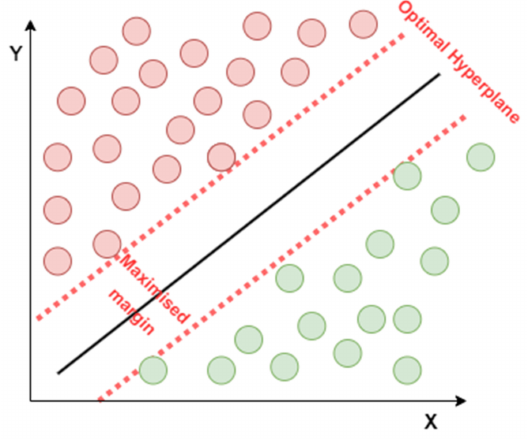
Figure 5. The idea of Support Vector